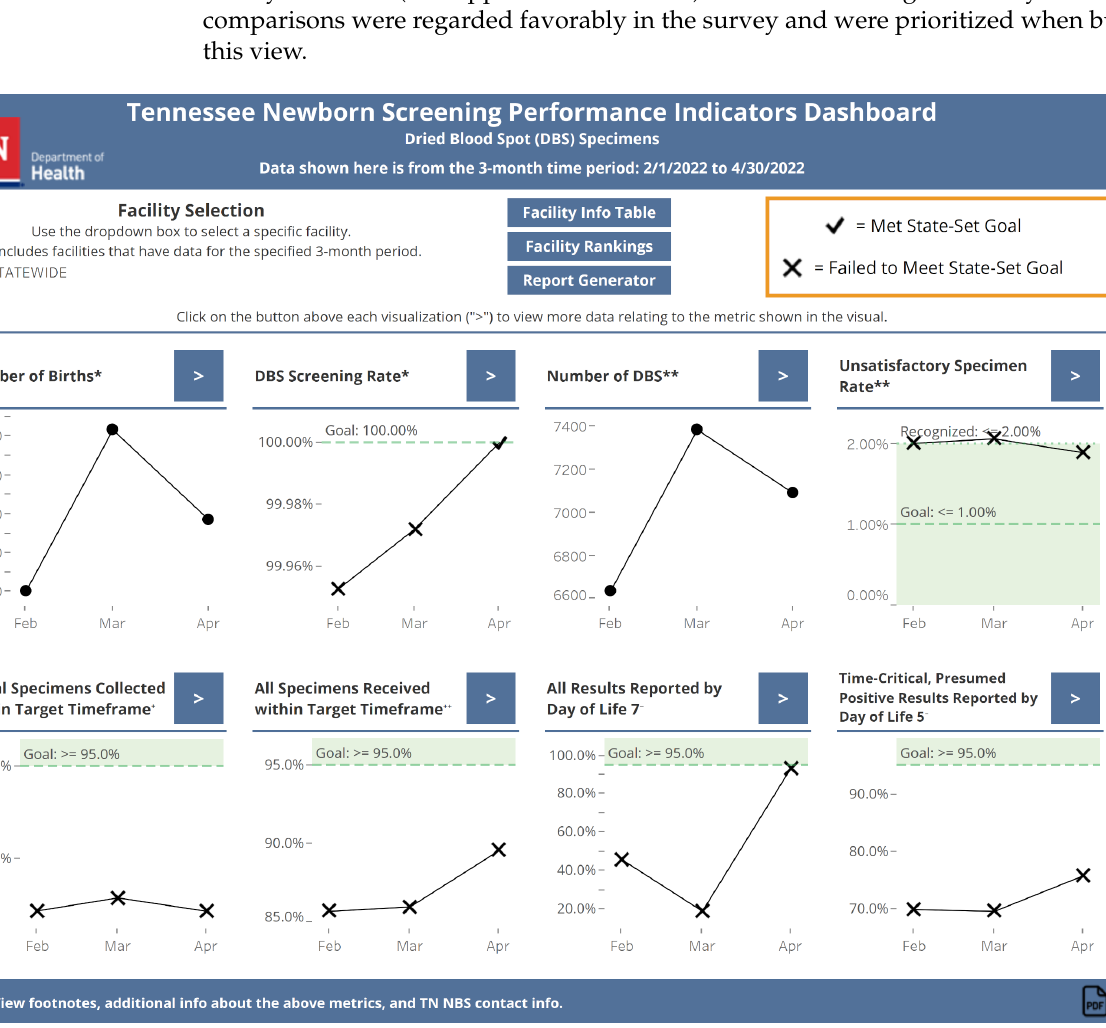
Figure 2. The default view of the dashboard’s main page as of June 2022. The three most recent months’ worth of data for all eight indicators are shown here with conditional formatting to indicate goal status where applicable. Buttons allow the user to navigate to other dashboard views. Markings like “*” and “**” indicate that the dashboard has footnotes that contain contextual information, similar to that given in Table 1, about the marked